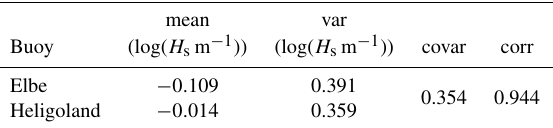
Table 2. Mean, variance (var), covariance (covar), and correlation (corr) parameters used for the simulation of the background wave height statistics at the locations of the Heligoland and Elbe buoys in the German Bight. These numbers were derived from measurements taken during the period June 2016–April 2017. The respective prob- ability distributions with a log-normal approximation are shown in Fig. 4. mean var Buoy (log( H s m − 1 )) (log( H s m − 1 ))